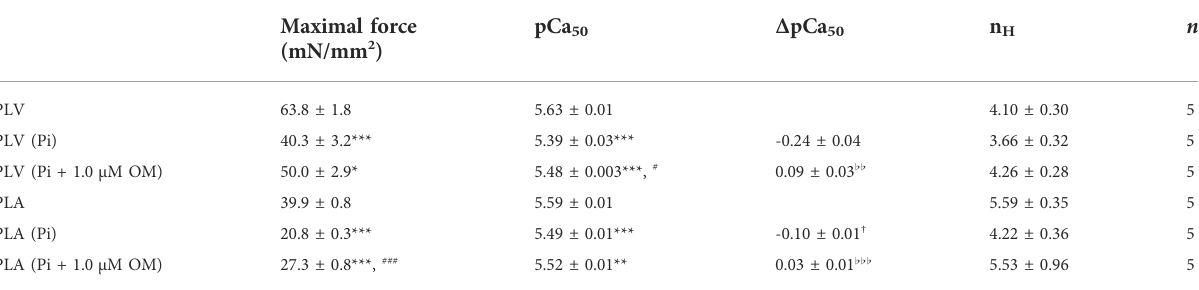
TABLE 4 Summary of the effects of OM on maximal force, Ca 2+ sensitivity and n H in PLV and PLA under depressed activation